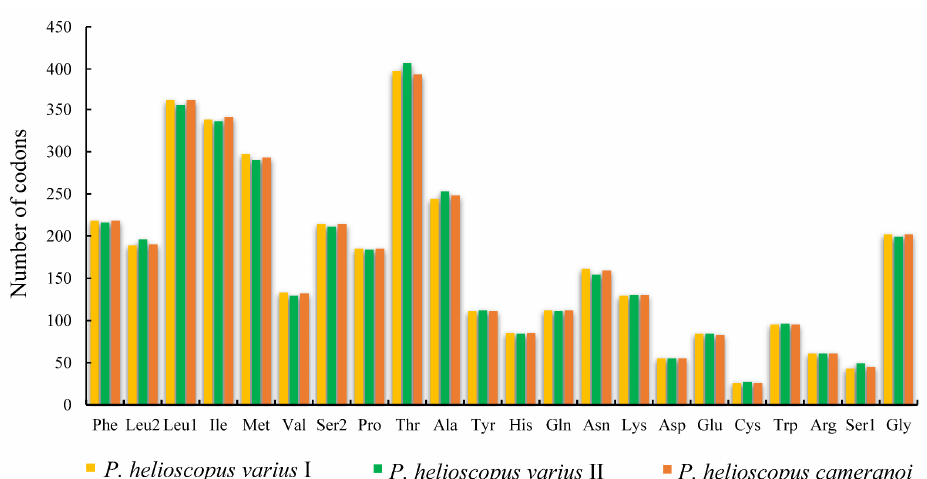
Figure 3. Amino acid frequency in the mitogenomes of P. helioscopus varius I, P. helioscopus varius II, and P. helioscopus cameranoi . Numbers on the Y -axis refer to the total number of the codons and codon families are provided on the X -axis.